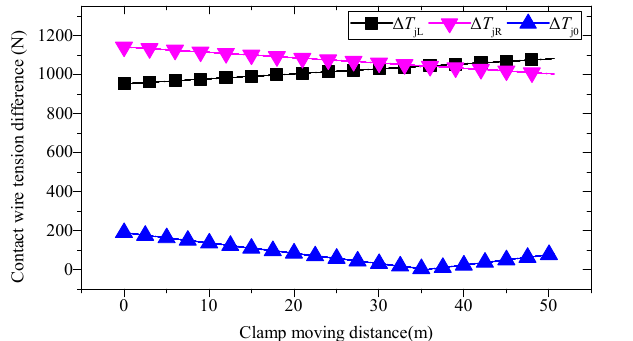
Figure 13. Changes of the trolley wire tension deviation when the mid-point anchor clip was at different positions.